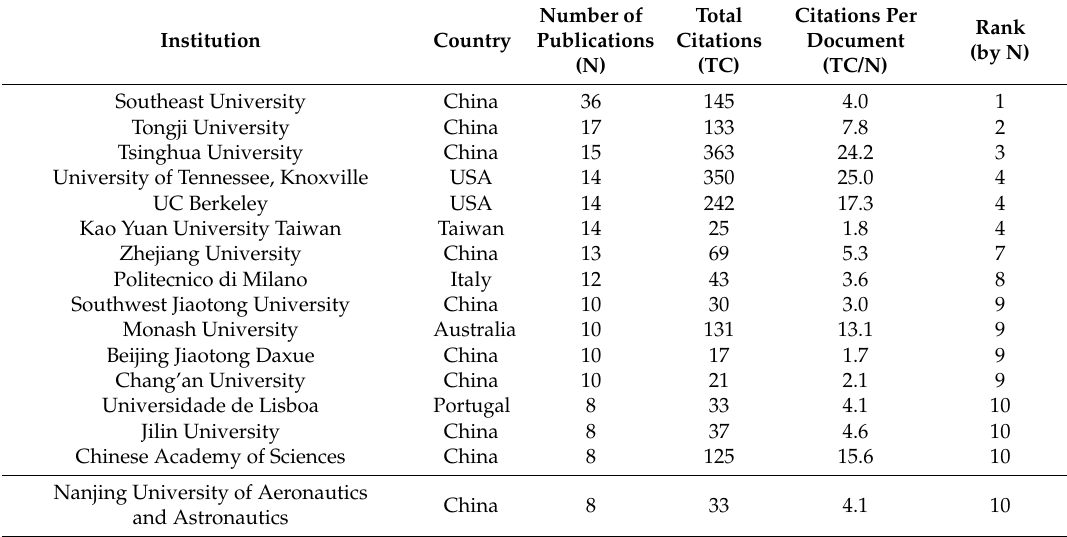
Table 1. Main institutions with research on electric bicycle and their main bibliometric